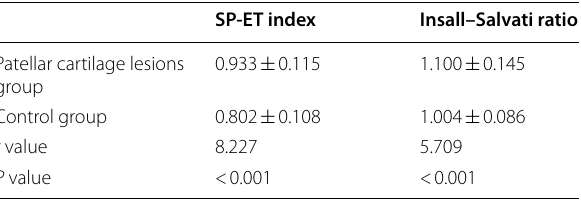
Table 3 Comparison of MR quantitative parameters between the patellar cartilage lesions group and control group